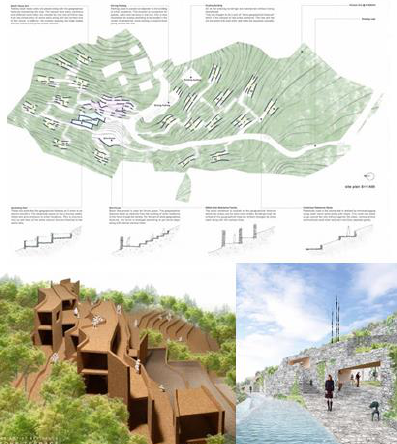
Figure 11. A Competition “Artist Residence in Boka” Winning project of Tomohiro Hata (Source: URL 3)